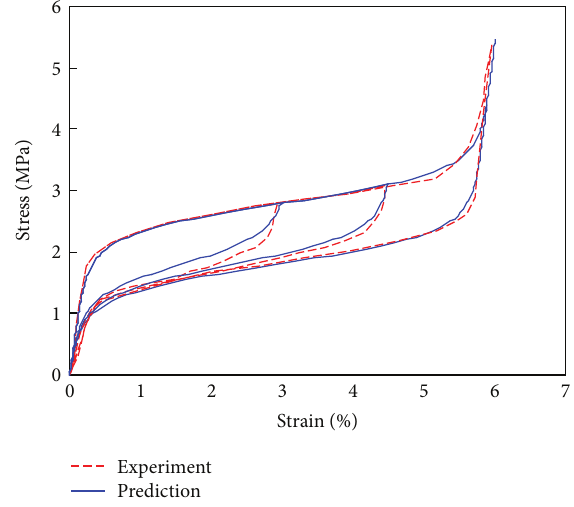
Figure 6: Minor hysteretic loops of magnetic shape memory alloy in martensite at